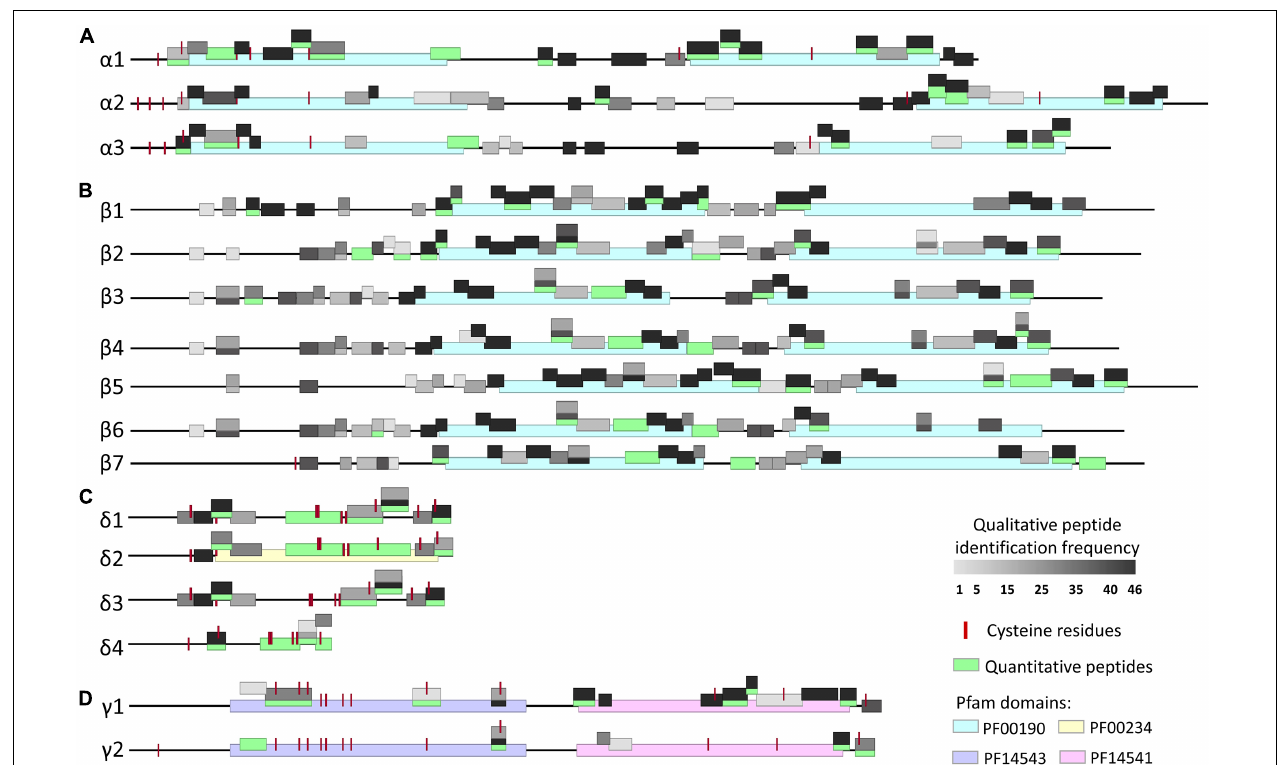
FIGURE 1 | Schematic representation of the main structural findings and conserved regions in (A) α -, (B) β -, (C) δ -, and (D) γ -conglutin sequences, as well as the marker peptides used in LC-MRM-MS measurement of these proteins. The Pfam domains are highlighted in blue (Cupin_1), yellow (Tryp_alpha_amyl), purple (TAXi_N), and pink (TAXi_C). The red lines show the position of cysteine residues, and the green blocks are representative of MRM marker peptides (quantitative peptides). The conglutin peptides identified by IDA (qualitative peptides) are depicted by gray blocks, wherein the darker color indicates sequence regions commonly identified across the analyzed lines (white blocks, 1–5 cultivars; black blocks, 40–46 cultivars).